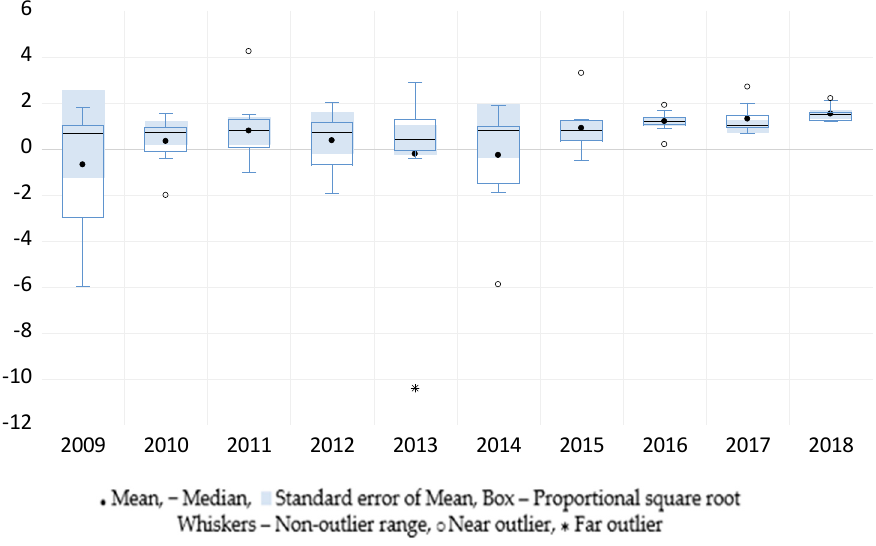
Figure 1. Boxplot of ROA in CEE countries, 1995–2018 (%).